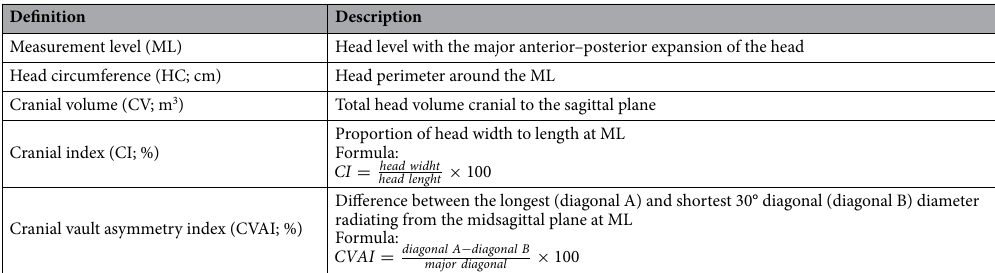
Table 1. Definitions and descriptions of parameters and measurements. Since all infants wore an eye protection during image acquisition, the point nasion was located centrally between the eyes and referred to as